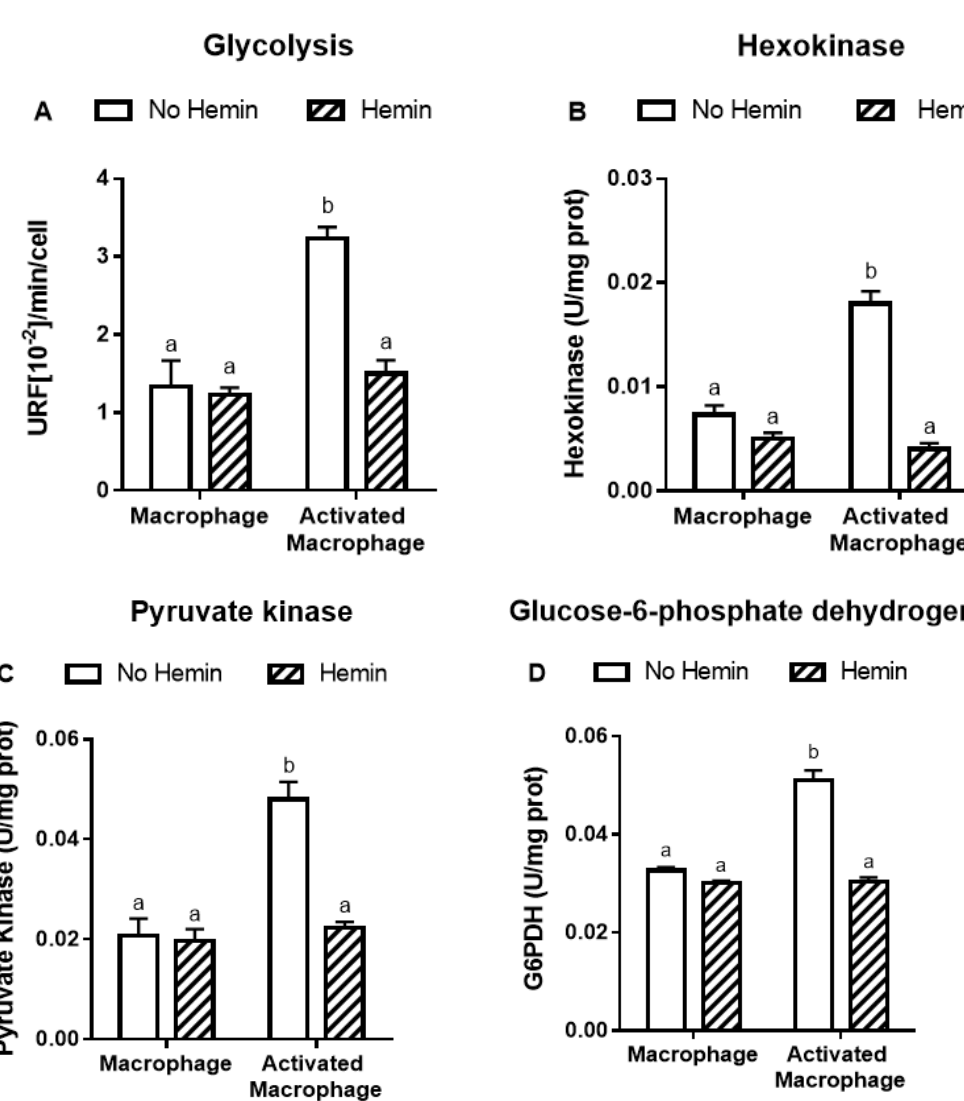
Figure 3. The increased glycolysis and metabolic enzyme activities of activated macrophages are reduced by hemin. ( A ) Glycolysis and the activities of ( B ) hexokinase, ( C ) pyruvate kinase, and ( D ) glucose-6-phosphate dehydrogenase were measured in macrophages and activated macrophages, in the absence or presence of 10 µ M hemin for 72 h. Activities of the enzymes were expressed as unit / mg protein, calculated as nmol of NADP reduced / min / mg protein for hexokinase and glucose-6-phosphate dehydrogenase, and as nmol of NADH oxidized / min / mg protein for pyruvate kinase. Values with different superscript letters (a and b) indicate significant differences ( p < 0.05) between groups. For all bars with the same letter, the difference between the means is not statistically significant. G6PDH, glucose-6-phosphate dehydrogenase. LPS and INF γ did not alter the levels of HIF-1 α in the nucleus; however, they increased HIF-1 α levels in the cytosol by 2.5-fold (Figure 4A,B). This increase observed in activated macrophages was abrogated by hemin (Figure